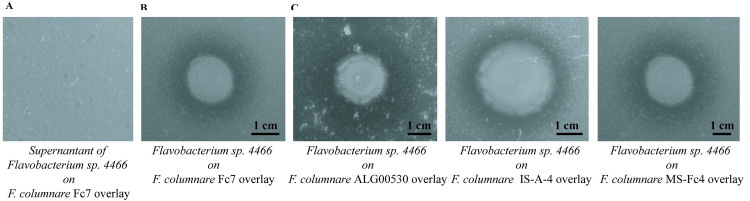
Representative images of in vitro growth-inhibition activity of Flavobacterium sp. strain 4466 against different virulent F. columnare strains.A: lack of F. columnare Fc7 growth-inhibition after adding 5 μl of Flavobacterium sp. culture supernatant. B: Halo of F. columnare FC7 growth inhibition surrounding Flavobacterium sp. colony on a F. columnare strain Fc7 overlay. C: Halo of growth inhibition of F. columnare ALG-00-530, IA-S-4, and Ms-Fc-4. The agar overlay technique was performed by spreading F. columnare bacterial suspension on soft-agar solution over TYES agar, and then spotting 5 μl of an overnight culture of Flavobacterium sp. strain 4466. Incubation was performed at 28°C for 24 h. This experiment was performed in triplicate.